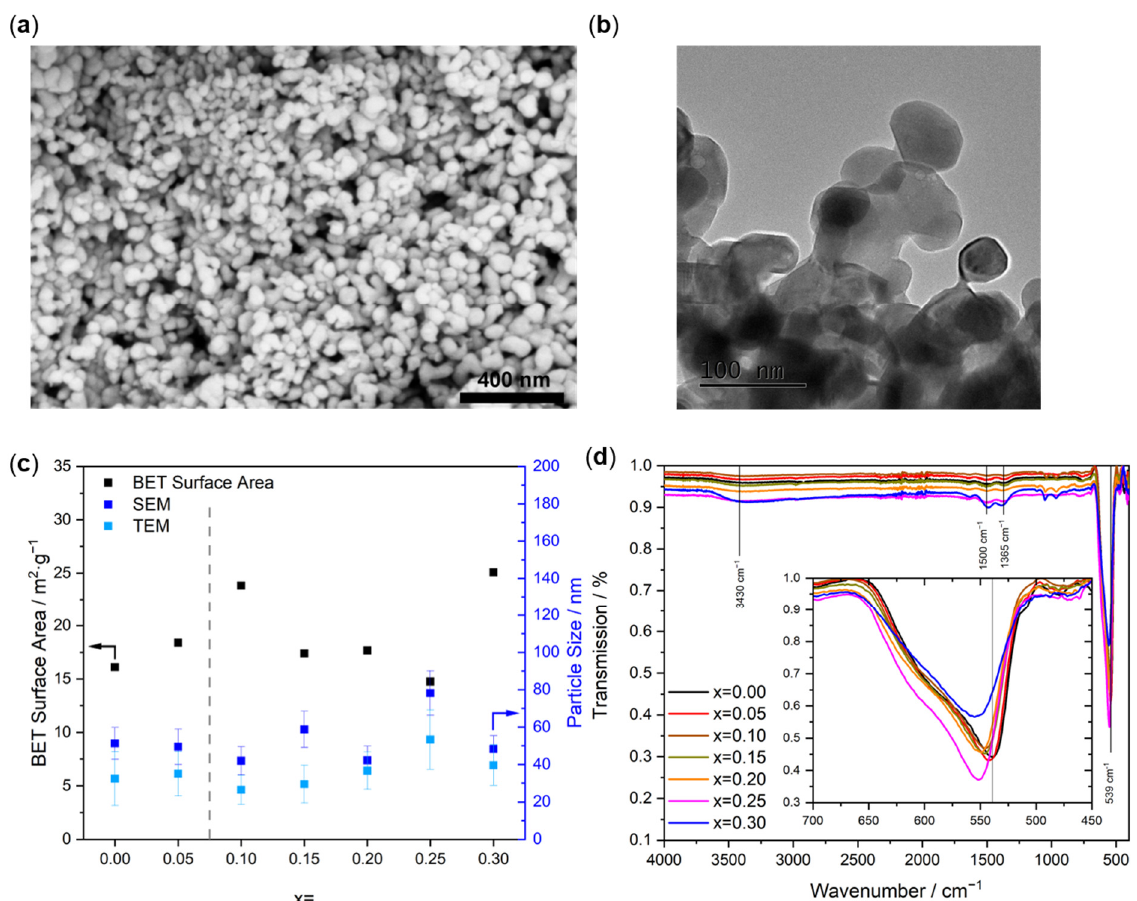
Figure 4. ( a ) SEM image of the sample with x = 0.05 after calcination. ( b ) TEM image of the sample with x = 0.05 after calcination. ( c ) BET surface areas compared to the particle diameters. ( d ) ATR-FTIR spectra of the samples after calcination.